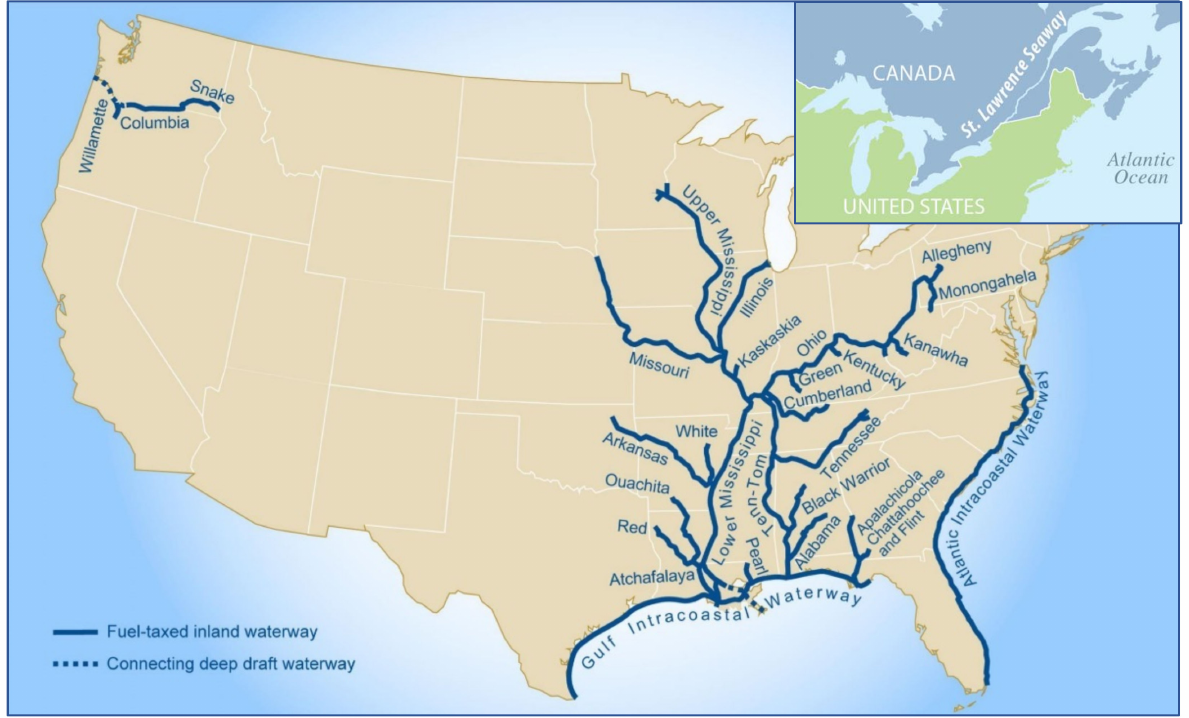
Figure 10. The inland waterways of the United States, including the St. Laurence Sea- way, shared between the United States and Canada. Source: U.S. Army Corps of Engineers and GAO (https://grains.org/grains-go-with-the-flow-u-s-inland-waterway-system-operating- normally-during-covid-19/, accessed on 16 February